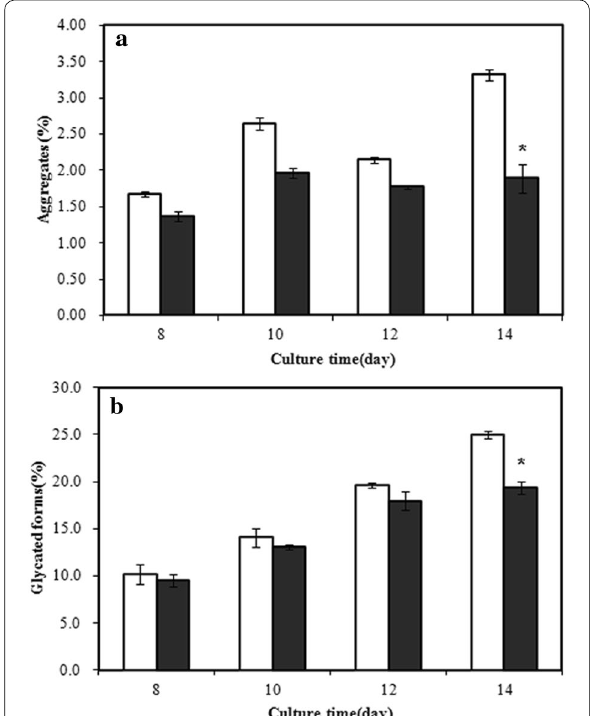
Fig. 4 Aggregate and glycated level during different culture process. a Aggregate level; b glycated level. (White bar) control condition; (shaded bar) uridine added condition. The error bars indicate the standard deviations from three independent experiments and p ‑values were estimated by two‑tailed Student’s t ‑test. * p < 0.05 relative to control